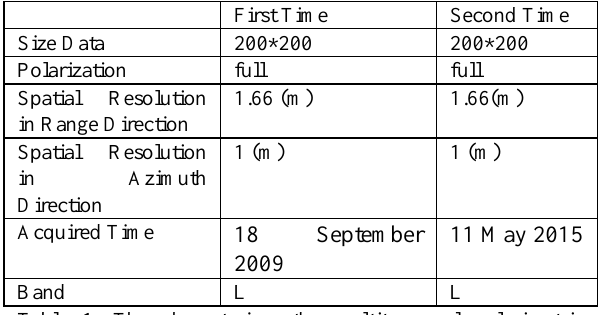
Table 1. The characterizes the multitemporal polarimetric dataset